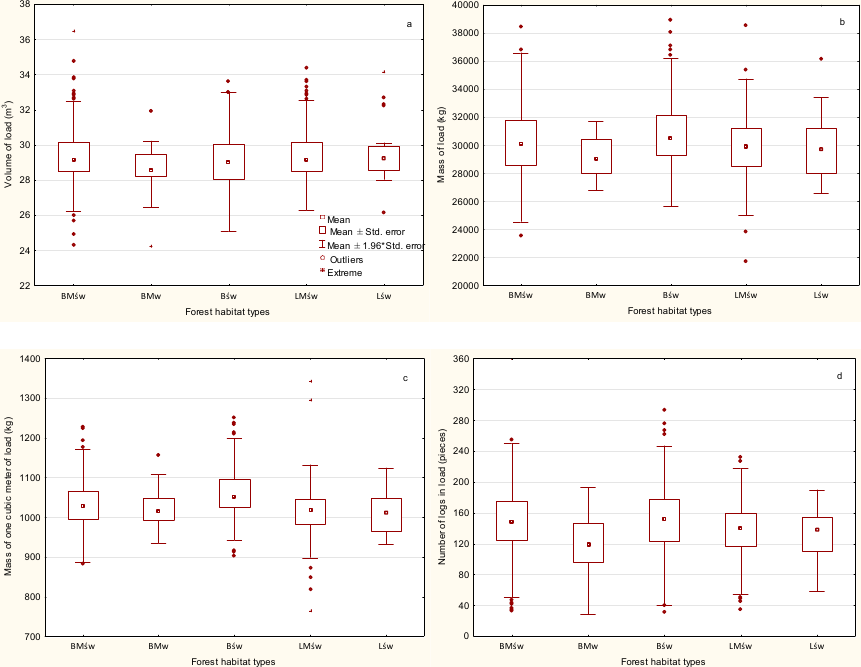
Figure 4. Comparison of average values characterizing timber loads depending on the type of forest habitat from which the timber was harvested. ( a ) load volume, ( b ) load mass, ( c ) mass of 1 m 3 , ( d ) number of logs (pieces). BM ś w − fresh mixed coniferous forest, BMw − moist mixed coniferous forest, B ś w − fresh coniferous forest, LM ś w − fresh mixed broadleaved forest, L ś w − fresh broadleaved forest. Analyses were performed of the influence of forest soil types occurring in the areas from which the timber loads originated on the examined characteristics. Loads from the five most frequent forest soil types (Bw, Bgw, RDb, RDbr, RDw) were analyzed (Figure 5), and no statistically significant differences were found for the results of load volume ( p = 0.4726) and load mass ( p = 0.634) depending on soil type. Figures 5a, 5b, 5c, 5d show small changes in median values for the examined characteristics and for the median results ± standard error. Statistically significant differences were found for the results of the mass of 1 m 3 of load and the number of logs (pieces) between RDbr soils and RDb, RDw as well as Bw soils (Figures 5c, 5d).